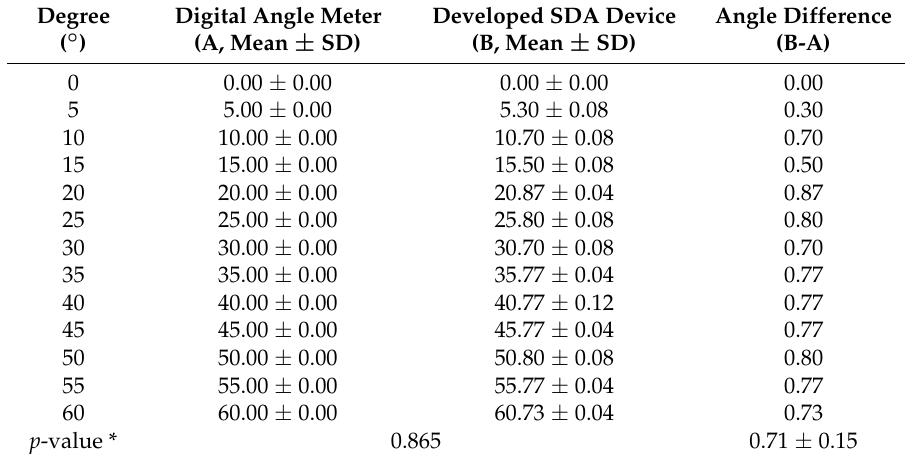
Table 1. Angle values and angle difference of digital angle meter and developed X-ray source-detector angle (SDA) device.